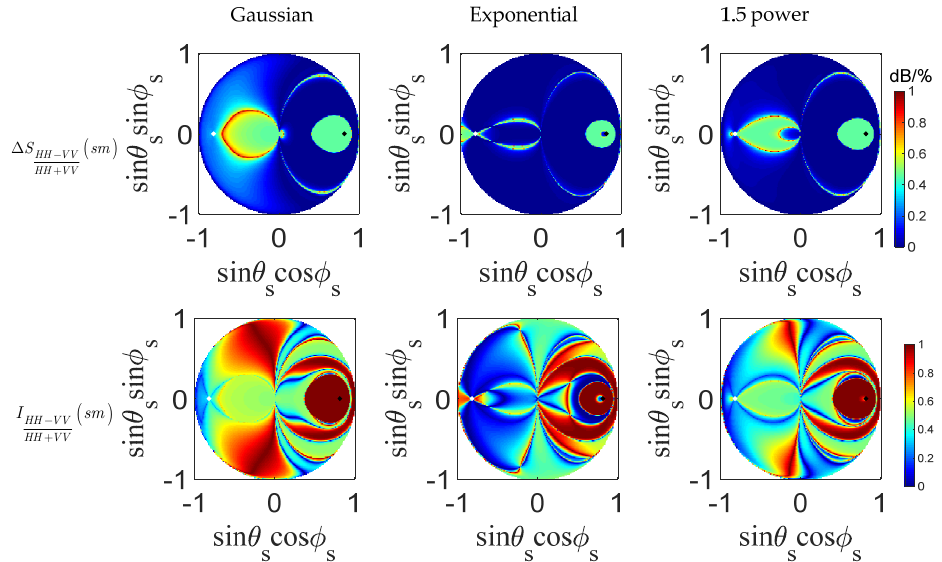
Figure 10. Patterns of sensitivity (𝜎 (cid:3009)(cid:3009)(cid:2868) −𝜎 (cid:3023)(cid:3023)(cid:2868) )/(𝜎 (cid:3009)(cid:3009)(cid:2868) +𝜎 (cid:3023)(cid:3023)(cid:2868) ) to soil moisture between 40% and 10% (first line), and the quality index I (second line).